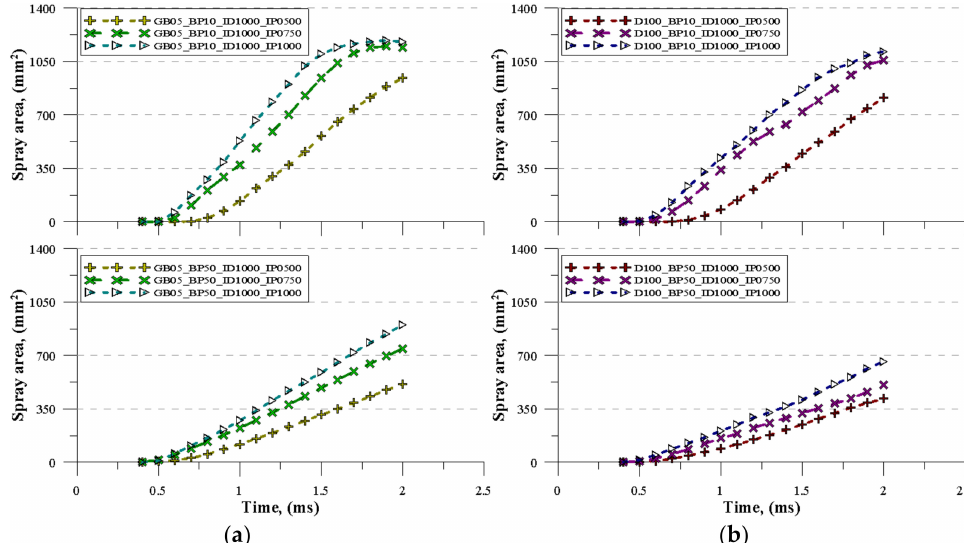
Figure 8. Spray area of ( a ) GB05, and ( b ) D100 with an injection duration 1000 µ s at back pressures of 10 and 50 bar and injection pressures of 500, 750 and 1000 bar.